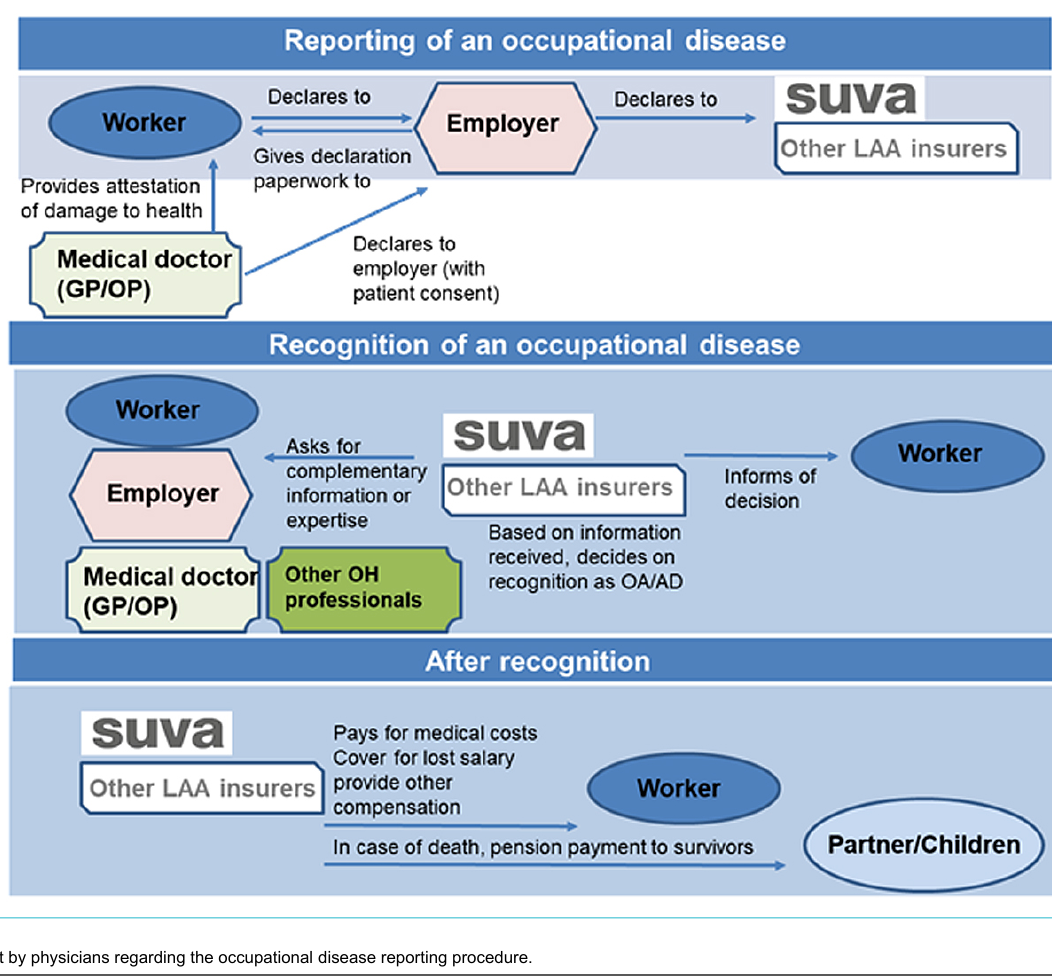
Figure 1: Reporting, recognition and compensation of an occupational disease in Switzerland. GP = general practitioner; OP = occupational physician; OH = occupational health; OA/D = occupational accident/disease.